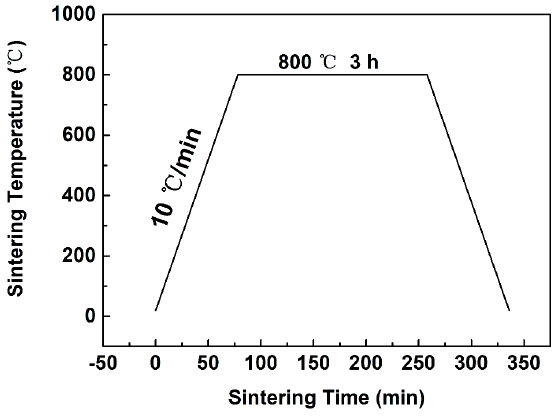
Figure 3. Sintering curve for HA (hydroxyapatite) coating on the as-printed 316L stainless steel substrate.